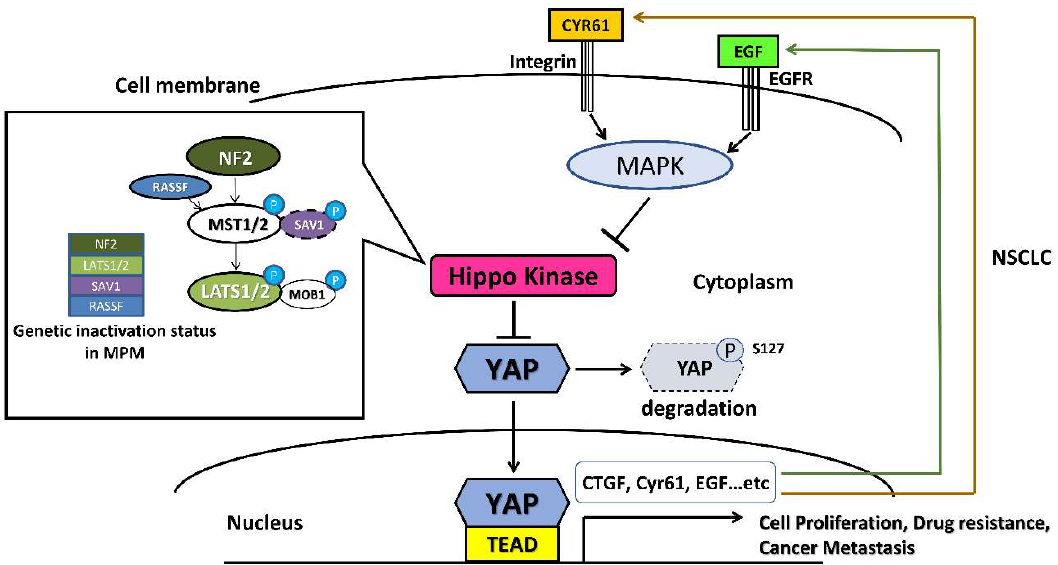
Figure 2. The regulation of the Hippo/YAP signaling pathway in malignant pleural mesothelioma (MPM) and non-small cell lung cancer (NSCLC). Hippo kinase, including NF2 and LATS1/LATS2, phosphorylate yes-associated protein (YAP) in the cytoplasm and lead to the degradation of YAP. In MPM, genetic mutations with loss of function in NF2, LATS1/LATS2, SAV1 and RASSF frequently occur, which leads to the degradation of YAP in the cytoplasm. Therefore, more YAP proteins translocate into the nucleus and activate transcription of downstream genes by forming complexes with transcriptional enhancer factors (TEAD), and promote tumorigenesis of MPM. In some NSCLC cells with high potential for drug resistance and metastasis, YAP expression increases at the protein level in the cytoplasm, and more YAP proteins translocate into the nucleus, which activates downstream genes including CTGF, cyr61 or other EGF expression genes, and then form autocrine loops to activate oncogenic pathways, such as MAPK signaling, which would inhibit the Hippo kinase. Therefore, the formation of these autocrine loops enhances YAP signaling, which promotes tumor cell proliferation, drug resistance and metastasis in NSCLC. Abbreviations: NF2, neurofibromatosis 2; LATS1, large tumor suppressor homolog 1; MST1, mammalian sterile-20 like kinase 1; SAV1, protein salvador homolog 1; RASSF, Ras-association domain family.